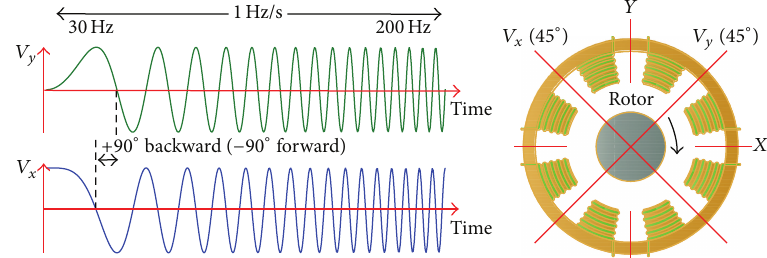
Figure 4: Current signal of the magnetic bearing exciter.